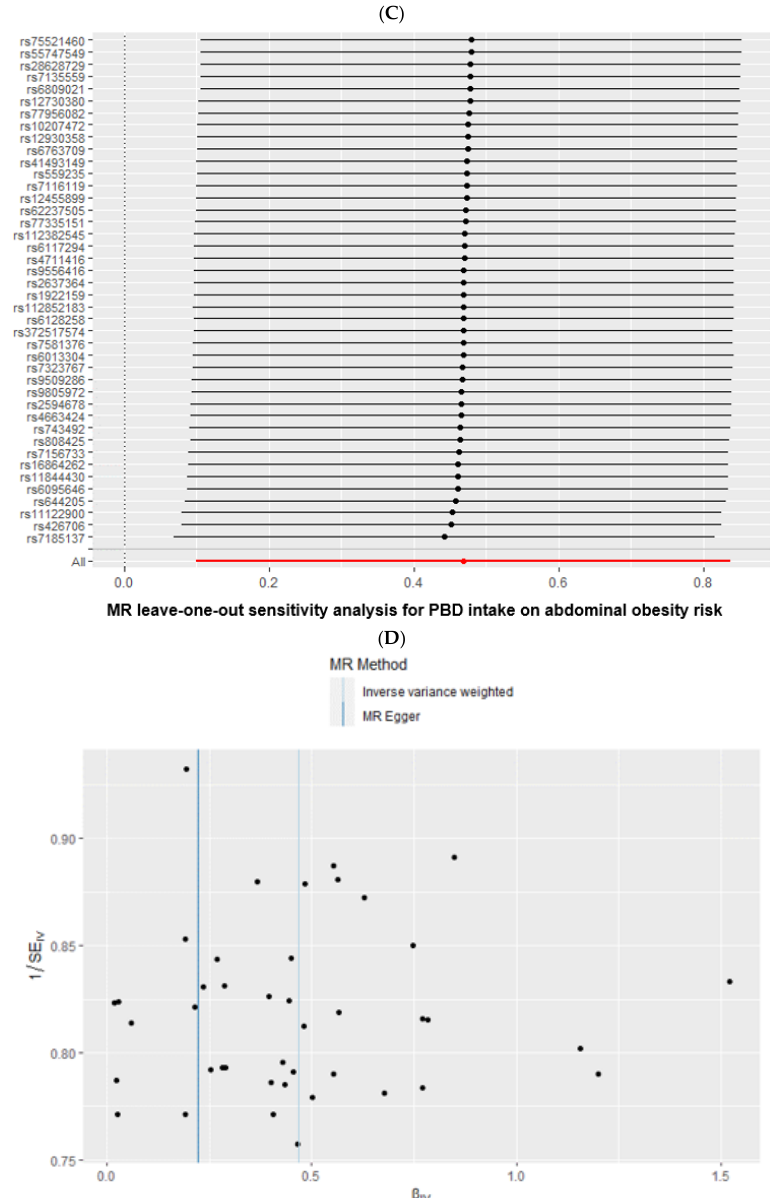
Figure 4. Association between plant-based diet (PBD) intake (cutoff: 67th percentiles) on abdominal obesity (AB) risk, determined by waist circumference (men, ≥ 90 cm and women, ≥ 85 cm) using a two-sample Mendelian randomization (MR) analysis. ( A ) Correlation between the effect size of the single nucleotide polymorphism (SNP)-PBD intake (x-axis, standard deviation (SD) units) and SNP-AB association (y-axis, log OR) to the SD bars. ( B ) Forest plot between PBD intake and AB. Each black dot represents an increase in the log OR of each SD in AB, using each SNP of PBD intake as a separate instrumental tool in the MR-Egger method. Both MR–Egger and inverse-variance weighting (IVW) indicated a combined causal estimate with all SNPs in a single instrumental variable, using random effects of MR-Egger and IVW. The horizontal lines in each SNP represented 95% confidence intervals. ( C ) Leave-one-out sensitivity analysis of MR for the dietary PBD intake on the AB. Each black dot indicates an IVW method for estimating the causal effect of PBD intake on AB, from which the single SNP was excluded. The IVW estimate was described using eight SNPs in the leave-one-out sensitivity analysis. ( D ) IVW and MR-Egger regression funnel plots for the PBD intake on the AB. The vertical line represented a causal estimate, using all SNPs combined into a single instrumental variable, for each IVW and MR-Egger